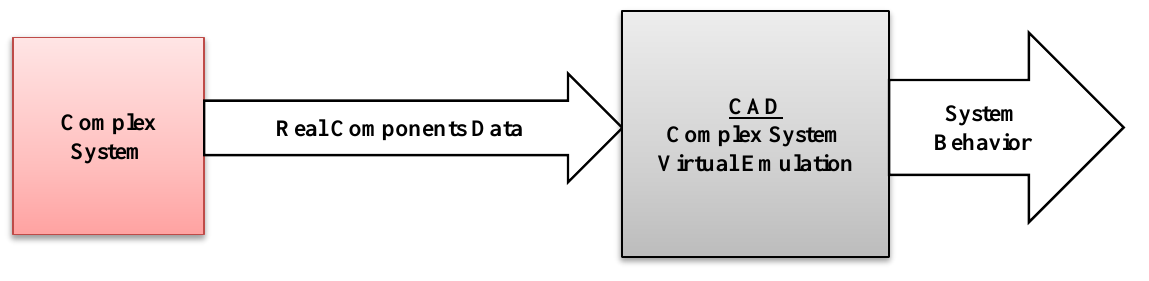
Figure 5. Representation of full digital CAD